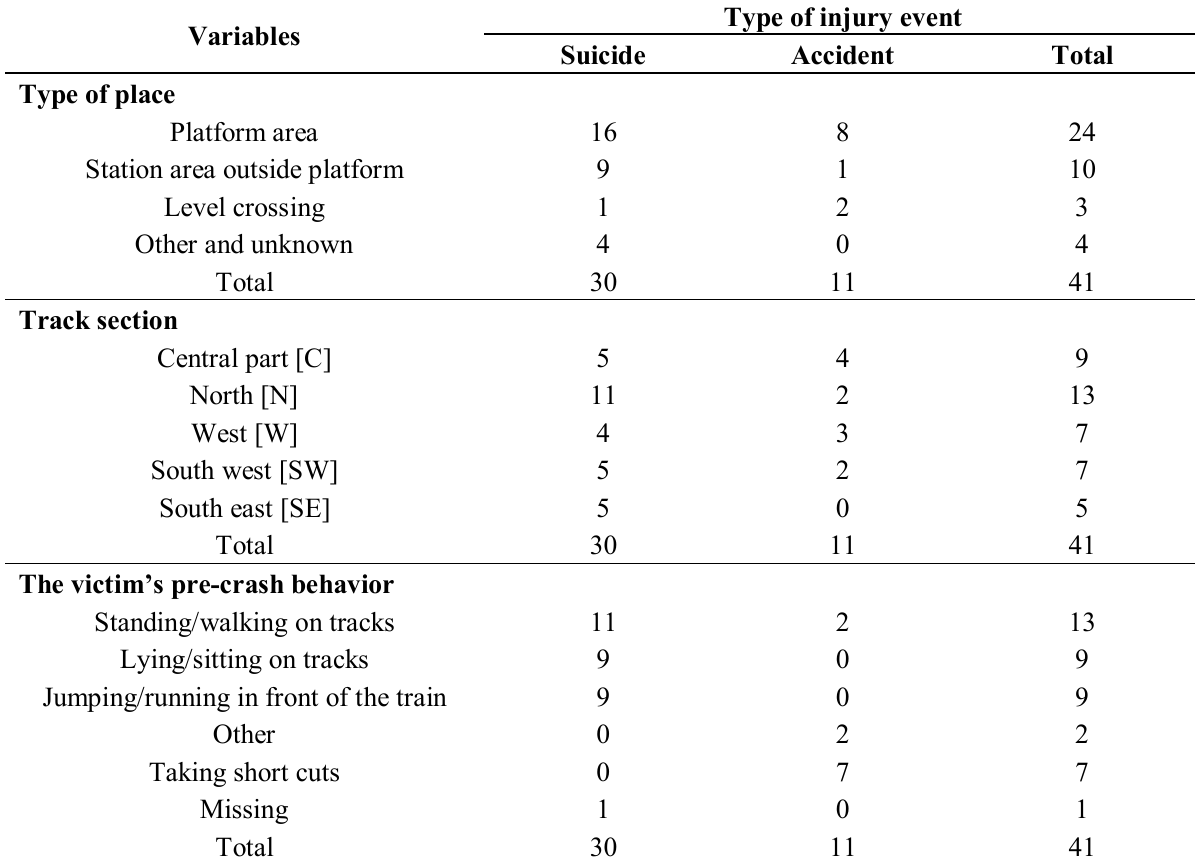
Table 3. Fatal train-person collisions by place, destination and pre-crash behavior on railway property in the greater Stockholm area,